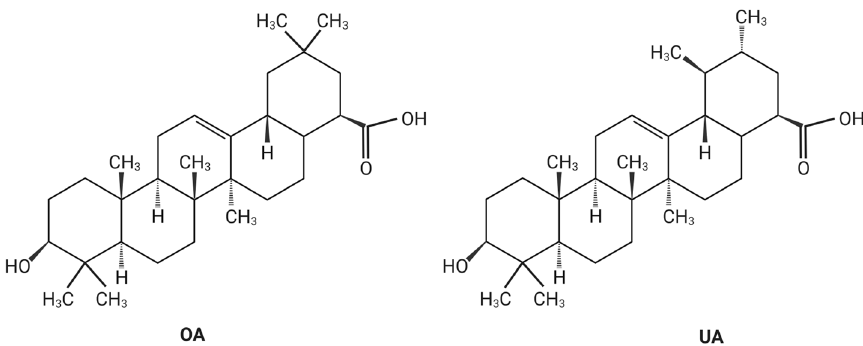
Figure 1. Chemical structures of oleanolic acid and ursolic acid (drawn according to [1]).